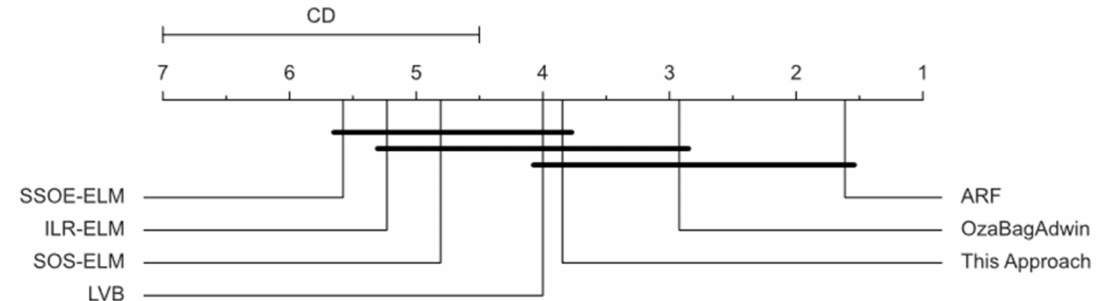
Figure 7. Critical Distance diagram of performance ranking comparison in artificial concept drift dataset.